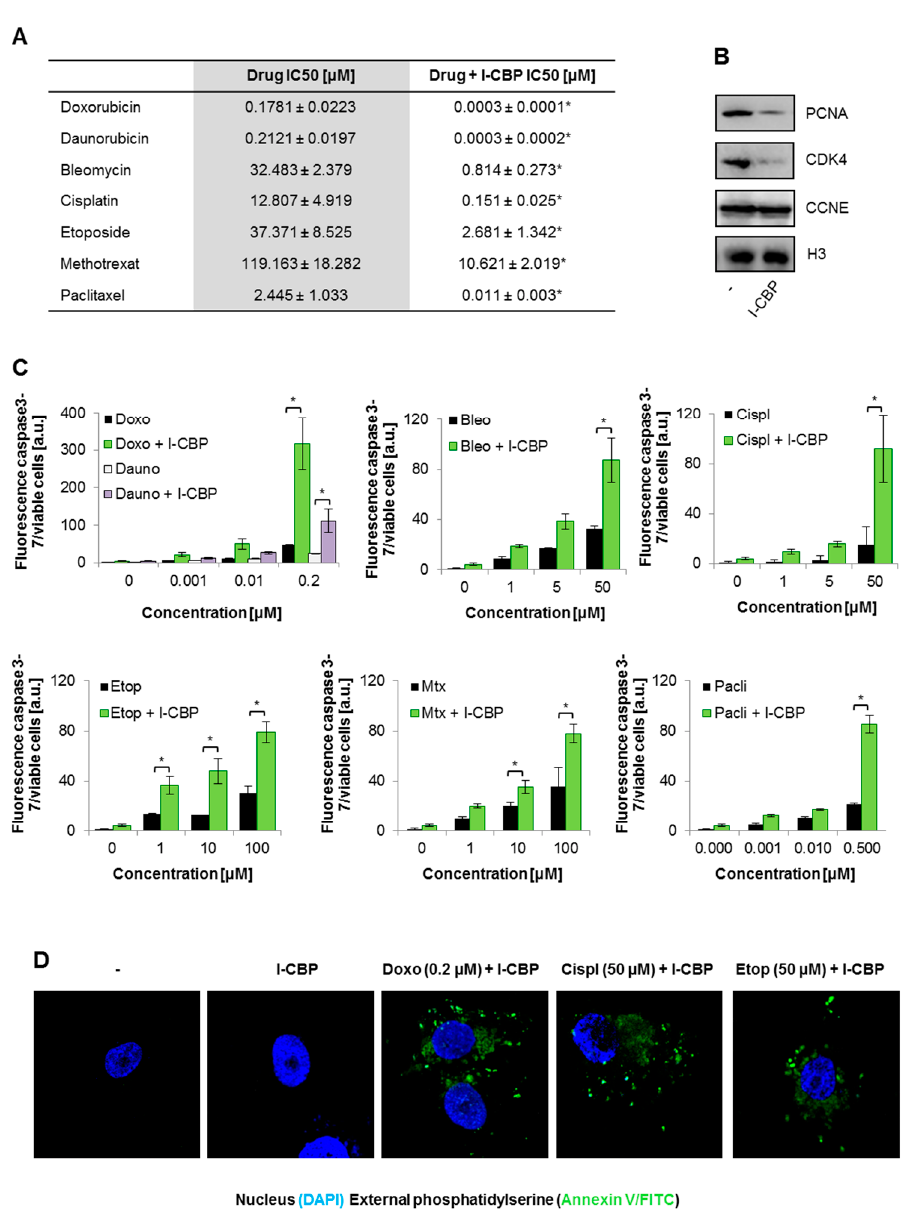
Figure 1. I-CBP inhibited proliferation and sensitized MDA-MB-231 breast cancer cells to anticancer drugs. ( A ) The half-maximal inhibitory concentrations (IC50s) for the seven studied drugs were calculated from the results of the resazurin-based viability assay. I-CBP112 (10 µ M) was added to cells for 72 h prior to treatment with chemotherapeutics, which were added for 48 h. The IC50 was determined using the binominal equation. ( B ) The effect of 72 h cell incubation with I-CBP112 on proliferation was studied by visualizing the protein levels of PCNA, CDK4, and CCNE in the compound-treated and untreated cells by Western blotting. H3 was used as the loading control. ( C ) The ratio between caspase-3/7 cleaved substrate and live-cell protease activity was quantified to estimate the modulatory potential of I-CBP112 (10 µM; 72 h) on drug-induced apoptosis. Features of apoptosis, necrosis, and living cells were monitored 24 h after their treatment with drugs. ( D ) Externalization of phosphatidylserine, which marks apoptotic cells, was monitored by confocal microscopy after cell staining with FITC-conjugated annexinV (green). DNA was stained with DAPI (blue). The scheme of cell treatment was the same as in ( C ). All data in bars are reported as mean ± SEM. ( A ) The difference between two means was tested with Student’s t -test, and statistically significant differences are marked with * when p < 0.05. ( C ) The impact of drug-induced apoptosis was tested with two-way ANOVA and the Bonferroni test. Statistically significant effects of I-CBP112 are marked with * when p <